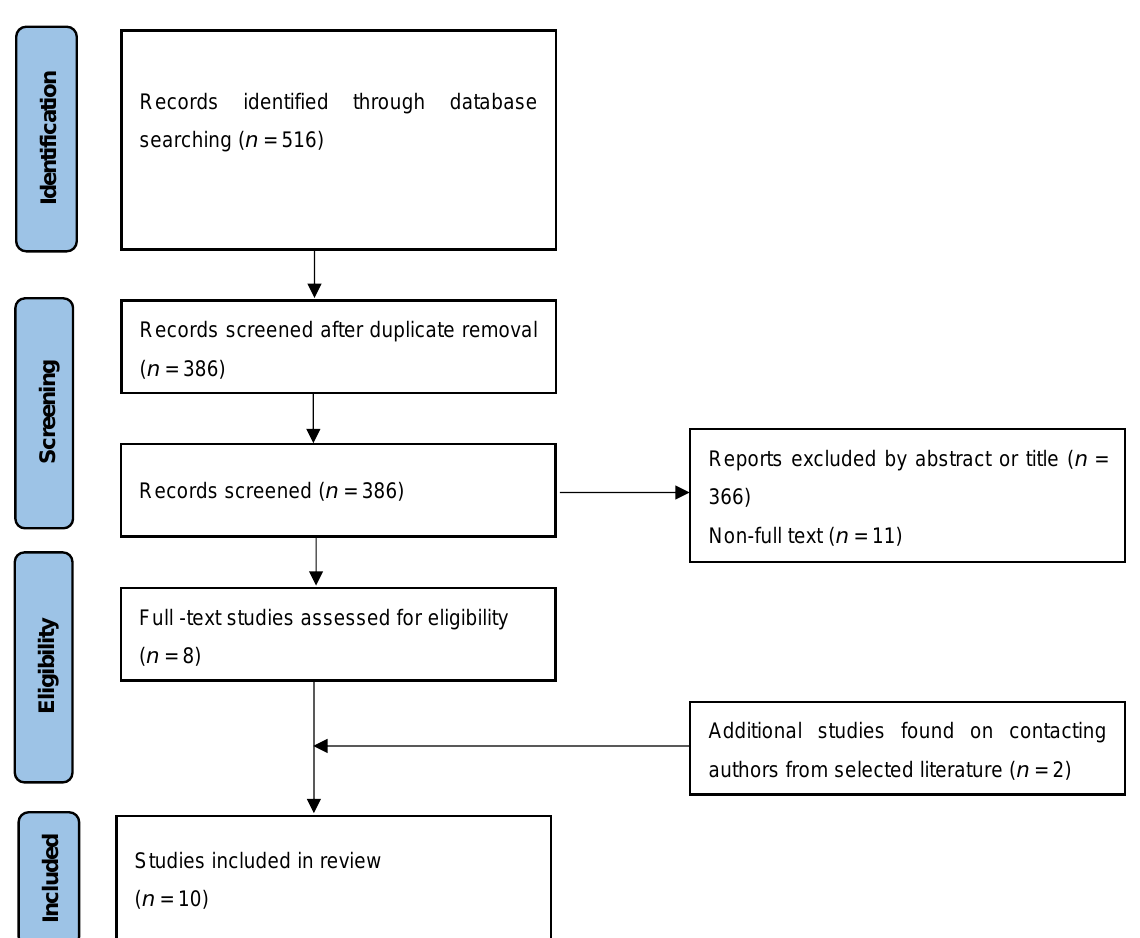
Figure 1. PRISMA flow diagram of evidence acquisition. PRISMA — Preferred Reporting Items for Systematic Reviews and Meta-Analysis.